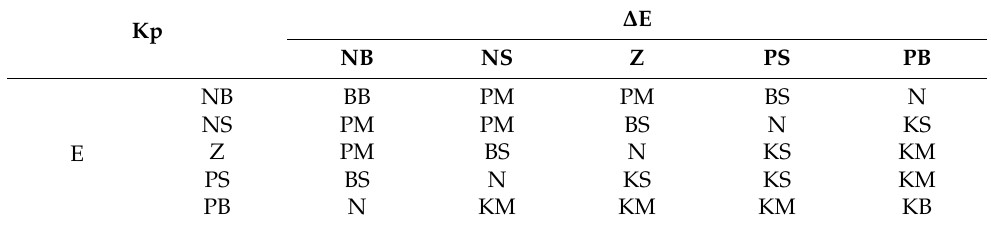
Table A1. Fuzzy -PID Tuning Rules for Constant Kp.